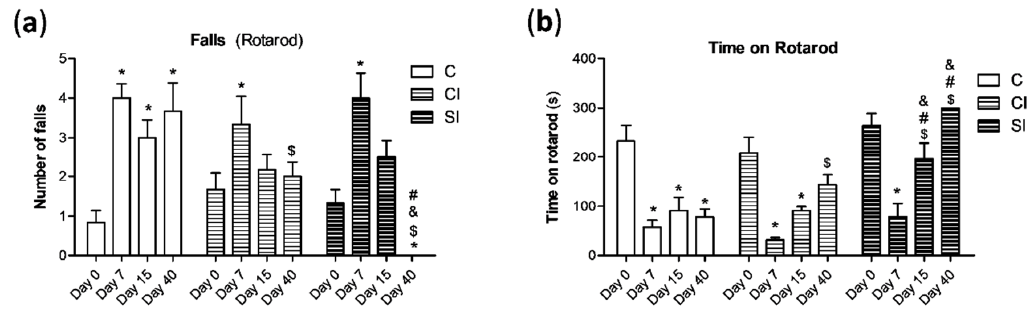
Figure 2. Analysis of the articular motor function with the Rotarod performance test. Animals from the three experimental groups were forced to move in the rotating cylinder for 300 s. The number of falls ( a ) during this period was monitored, as well as the time remaining on the rotarod ( b ). Values are mean ± SEM ( n = 6 independent animals for each condition). * p ≤ 0.05 vs. day 0; $ p ≤ 0.05 vs. day 7; & p ≤ 0.05 vs. the respective day in the C group; # p ≤ 0.05 vs. the respective day in the CI group. C, non-treated; CI, control injection; SI, H 2 S donor injection.